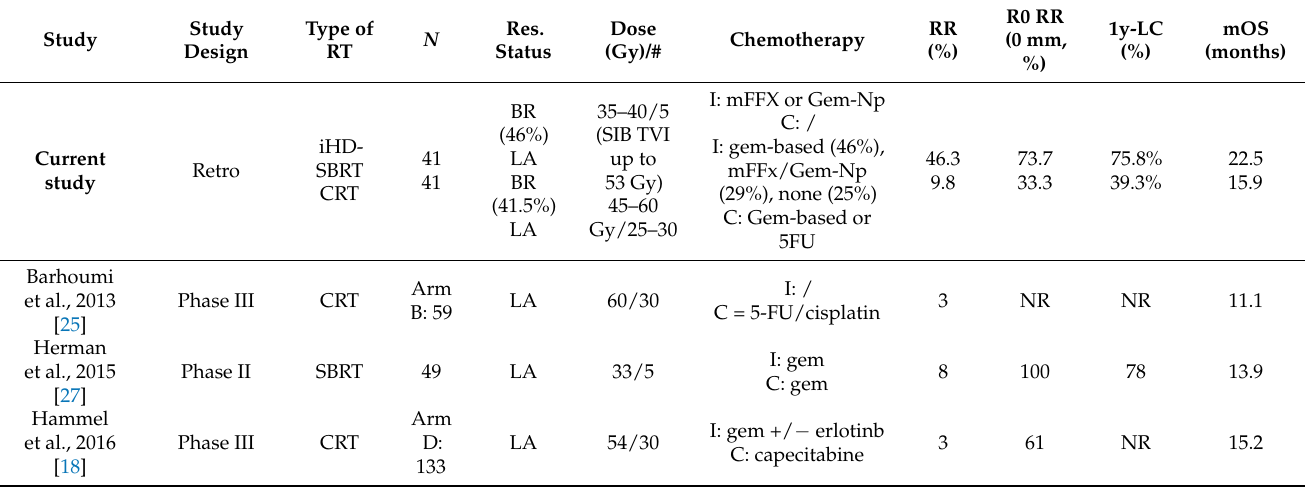
Table 5. Comparison of our survival outcomes with selected CRT and modern pancreatic SBRT trials available in the